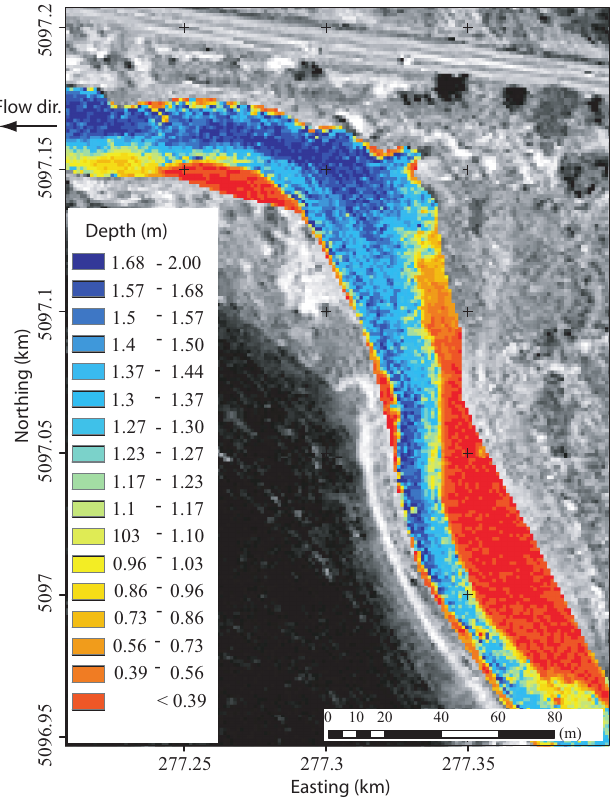
Figure 8. Variation of underwater depth in a 60 ◦